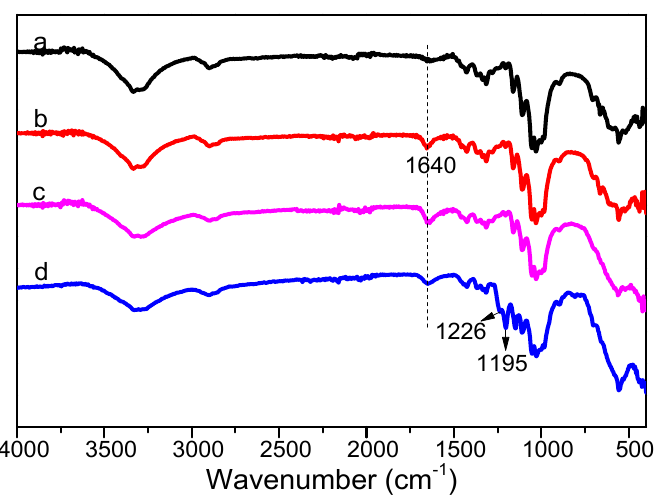
Figure 2. FT-IR spectra of ( a ) raw cotton fabrics, ( b ) PVP-modified cotton fabrics, ( c ) Fe 3 O 4 -modified cotton fabrics, and ( d ) Fe 3 O 4 -modified cotton after fluorination treatment.